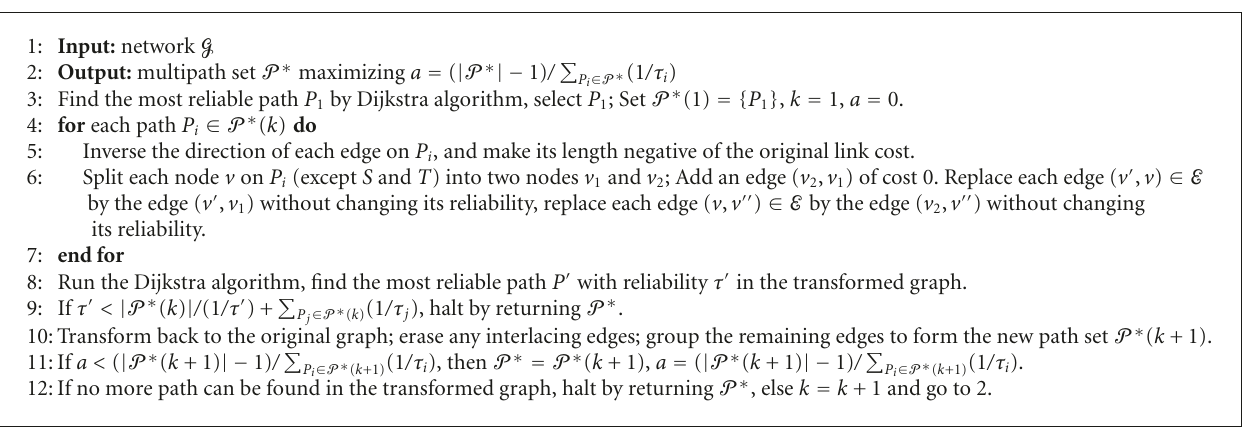
Algorithm 2: Heuristic path set computation